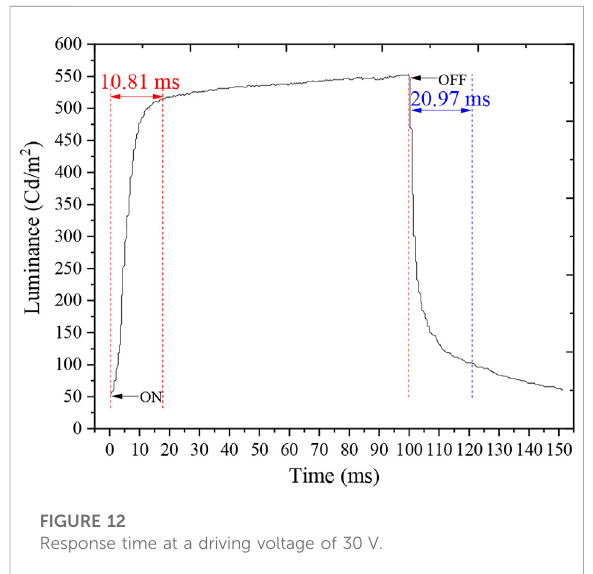
FIGURE 12 Response time at a driving voltage of 30